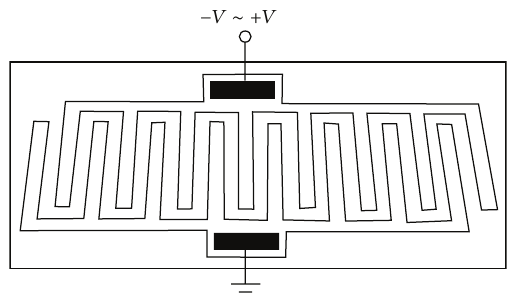
Figure 1: Schematic diagram of the MSM diodes with two multifinger Schottky contacts.